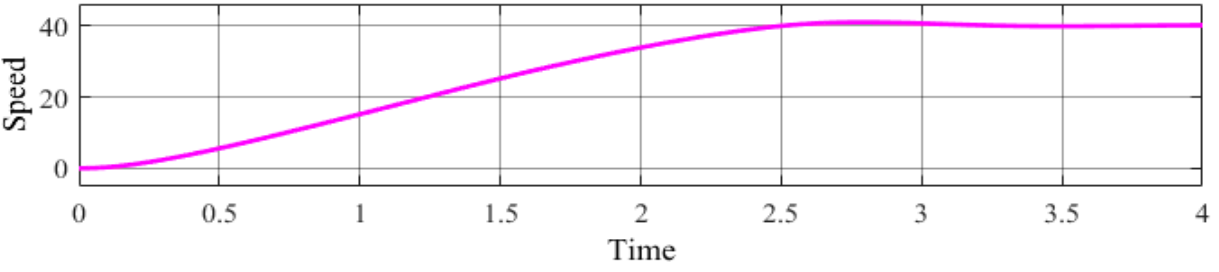
Figure 9. Speed response of the motor without performing the optimization.